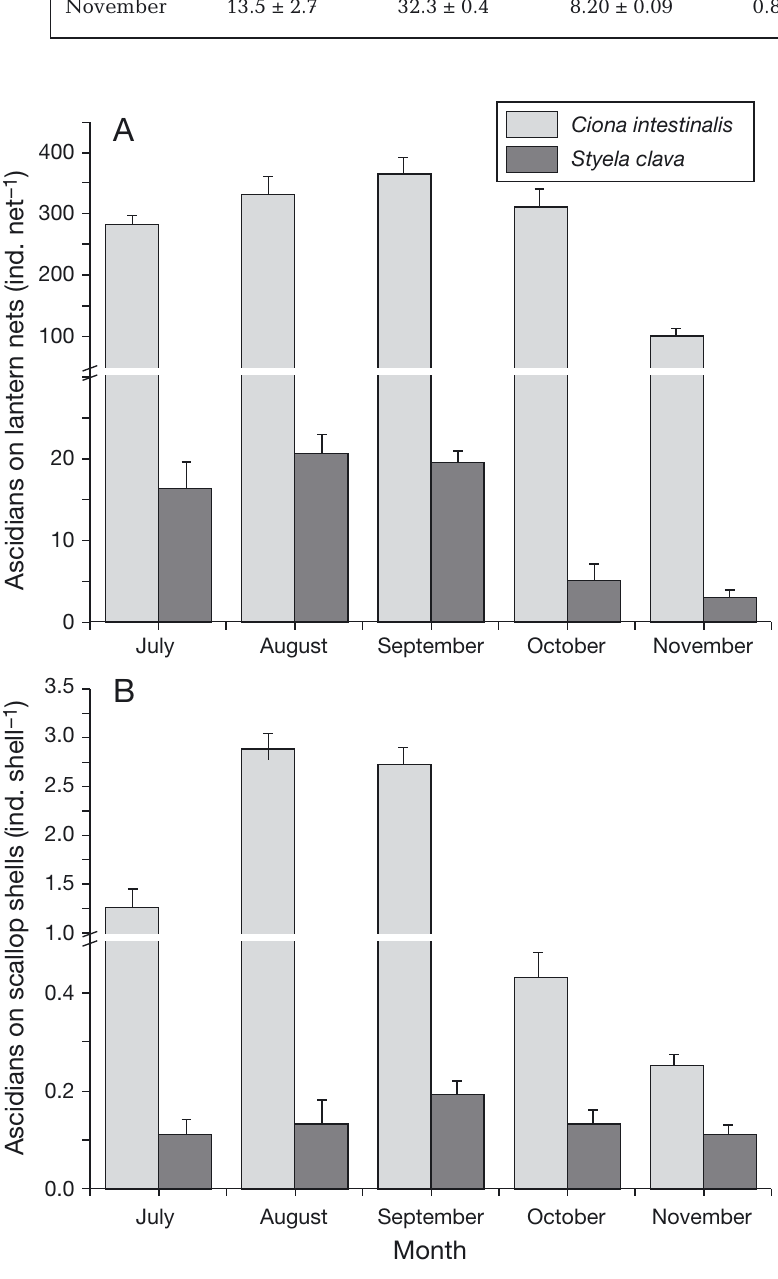
Fig. 1. Mean number (± SE) of ascidians Ciona intestinalis and Styela clava on (A) lantern nets and (B) shells of the scallop Chlamys farreri in